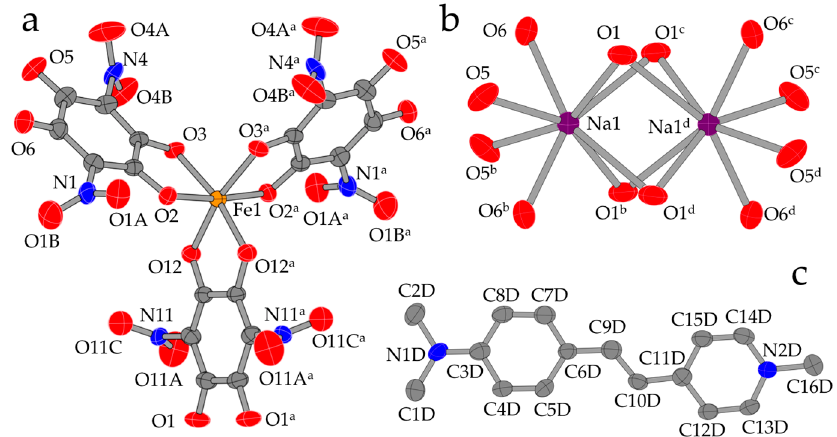
Figure 1. Ortep views of the fragments of the structure of compound 1 with the labeling scheme: ( a ) structure of the [Fe(C 6 N 2 O 8 ) 3 ] 3 − unit; ( b ) structure of the Na 2 O 12 dimer; ( c ) structure of the DAMS + ( a ) structure of the [Fe(C 6 N 2 O 8 ) 3 ] 3 ´ unit; ( b ) structure of the Na 2 O 12 dimer; ( c ) structure of the cation. DAMS +